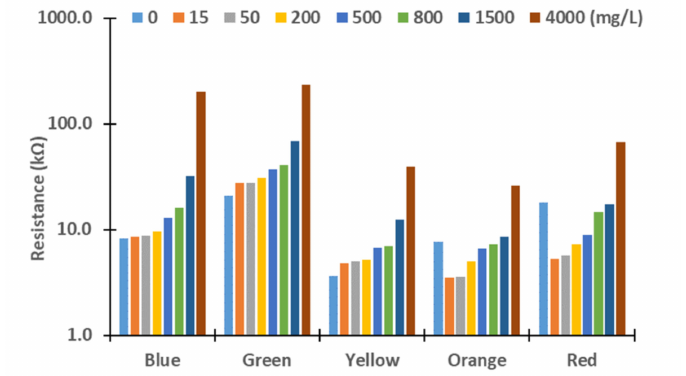
Figure 6. Measured resistance values for mixture 80% sediment and 20%